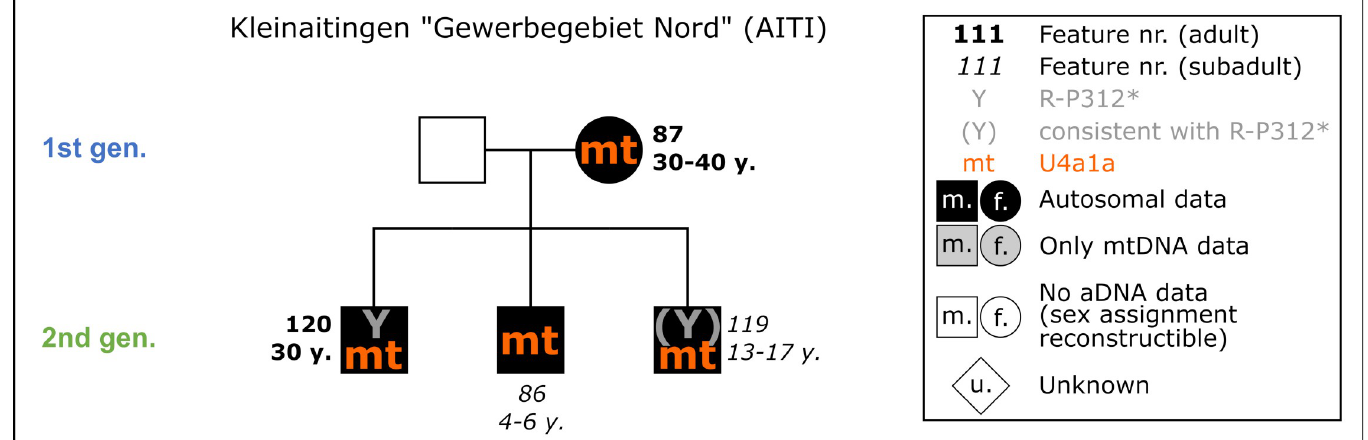
Fig 9. Pedigree of the nuclear family from AITI based upon evidence from aDNA analysis. The nuclear family includes a mother and her two subadult sons and an adolescent son. Ancient DNA analysis includes the coefficient of relatedness, shared mtDNA haplotypes and Y-haplogroups. Feature number and AaD estimate are depicted alongside the symbol for each